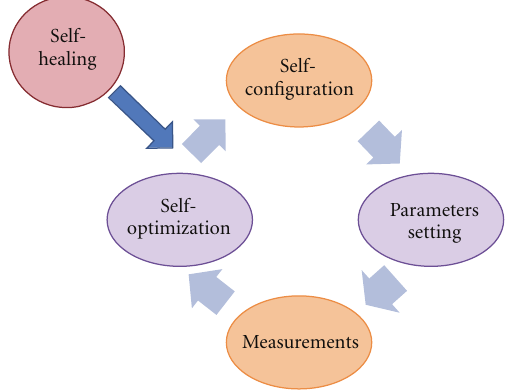
Figure 2: Life cycle of a self-organizing